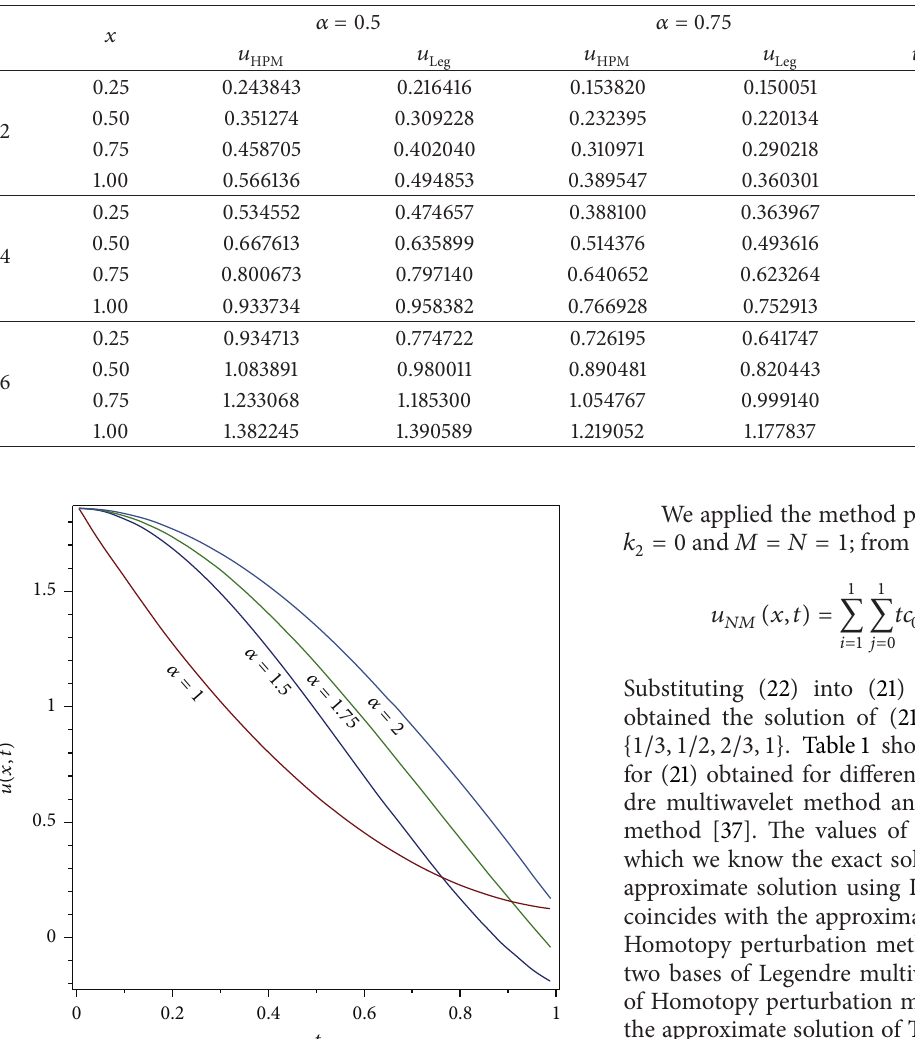
Table 6: Numerical values when 𝛼 = {0.5, 0.75, 1} .